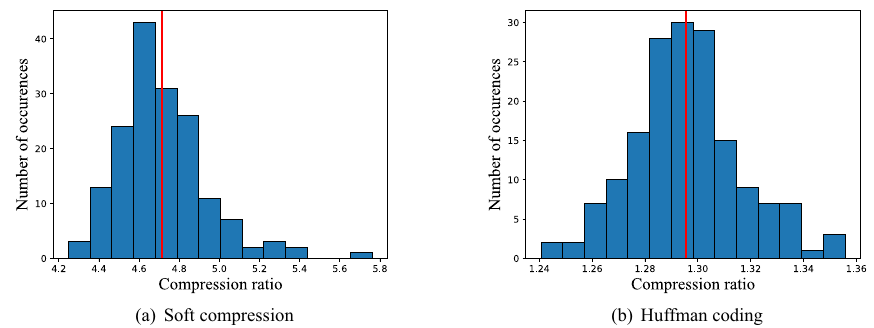
Figure 4. The histogram of compression ratio of BCCD dataset with soft compression algorithm for multi- component image and Huffman coding. ( a ) Soft compression. ( b ) Huffman coding (The compression ratio is defined as the number of bits required for natural binary code divided by another specific coding method when representing the same